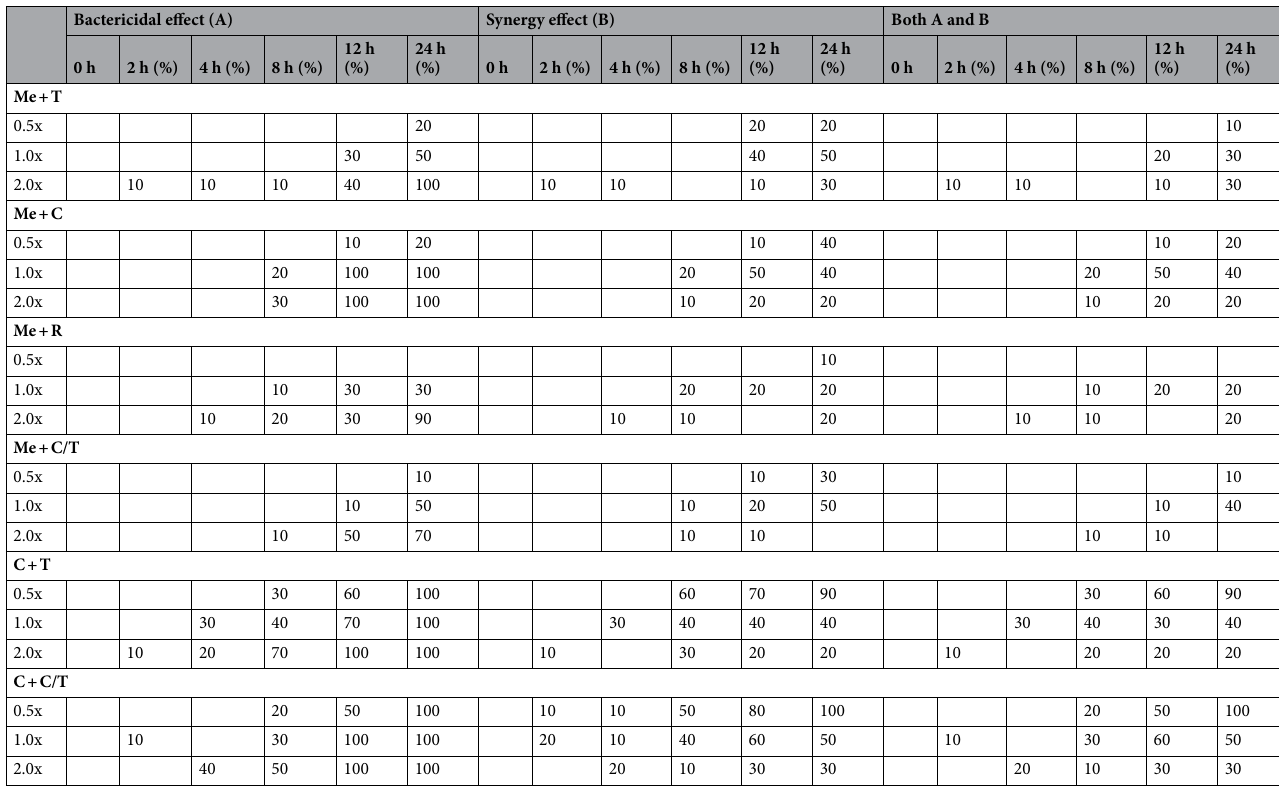
Table 5. Results of time-kill assays and the bactericidal effect of two-drug combinations against 10 Acinetobacter baumannii isolates. The percentage values indicate the ratio of isolates showing bactericidal or synergistic effects among all 10 CRAB isolates. C colistin, C/T ceftolozane/tazobactam, Me meropenem, R , rifampin, T tigecycline.